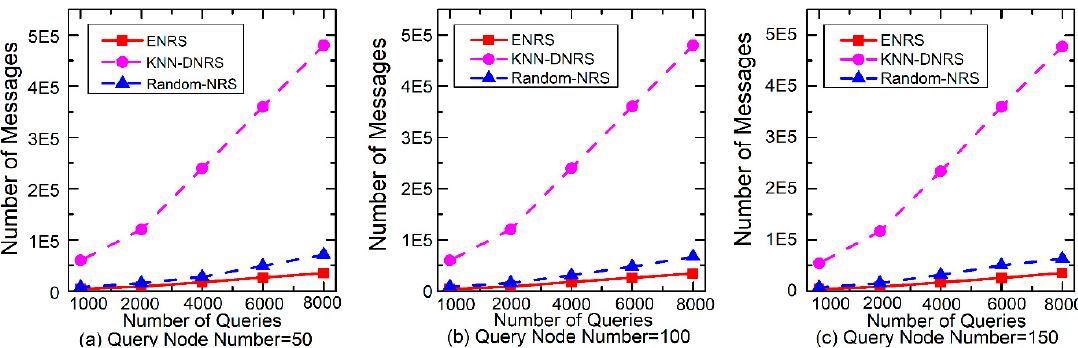
Figure 9 . The total number of messages versus the numbers of queries ; the number of nodes = 200. ( a ) shows the total number of messages with different number of queries when the number of query nodes is 50. ( b ) shows the variation of total number of messages with different number of queries when the number of query nodes is 100. ( c ) shows the total number of messages when the number of query nodes is 150.